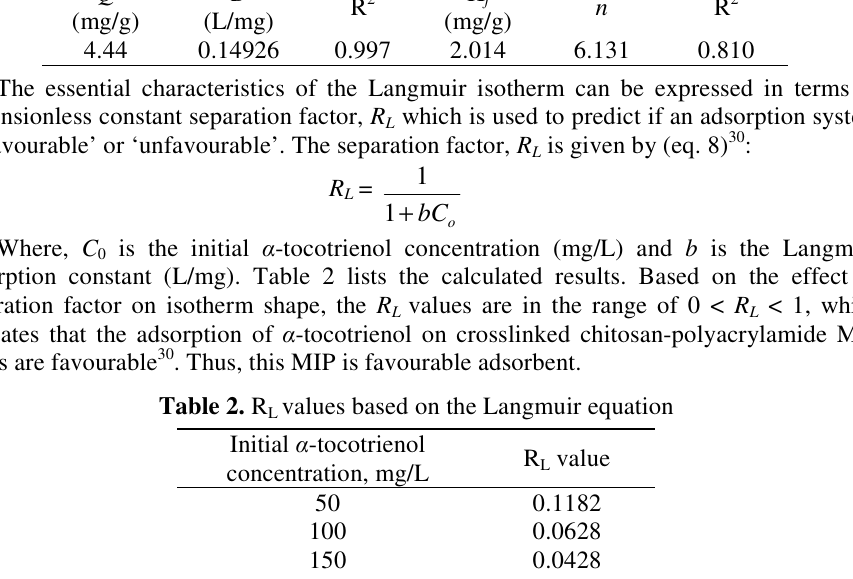
Table 1. Langmuir and Freundlich isotherm model constants and correlation coefficient Langmuir Isotherm Freundlich Isotherm Q